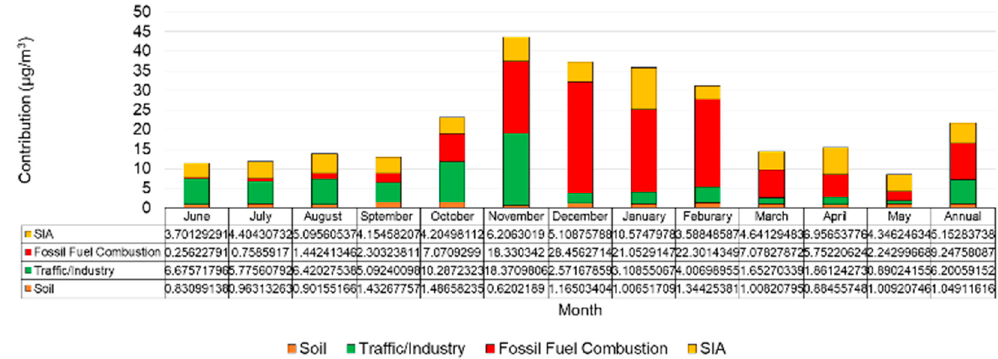
Figure 5. The monthly contribution of sources to PM2.5 mass in µg/m 3 .